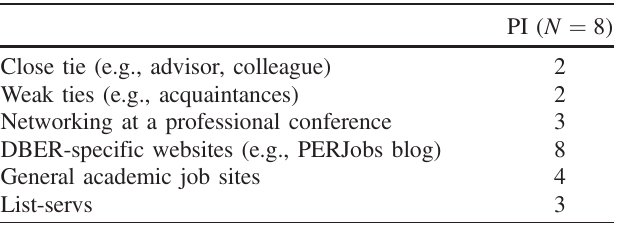
TABLE II. Where PIs search for postdocs. Interviewees used multiple methods, so the totals are much larger than the sample size.